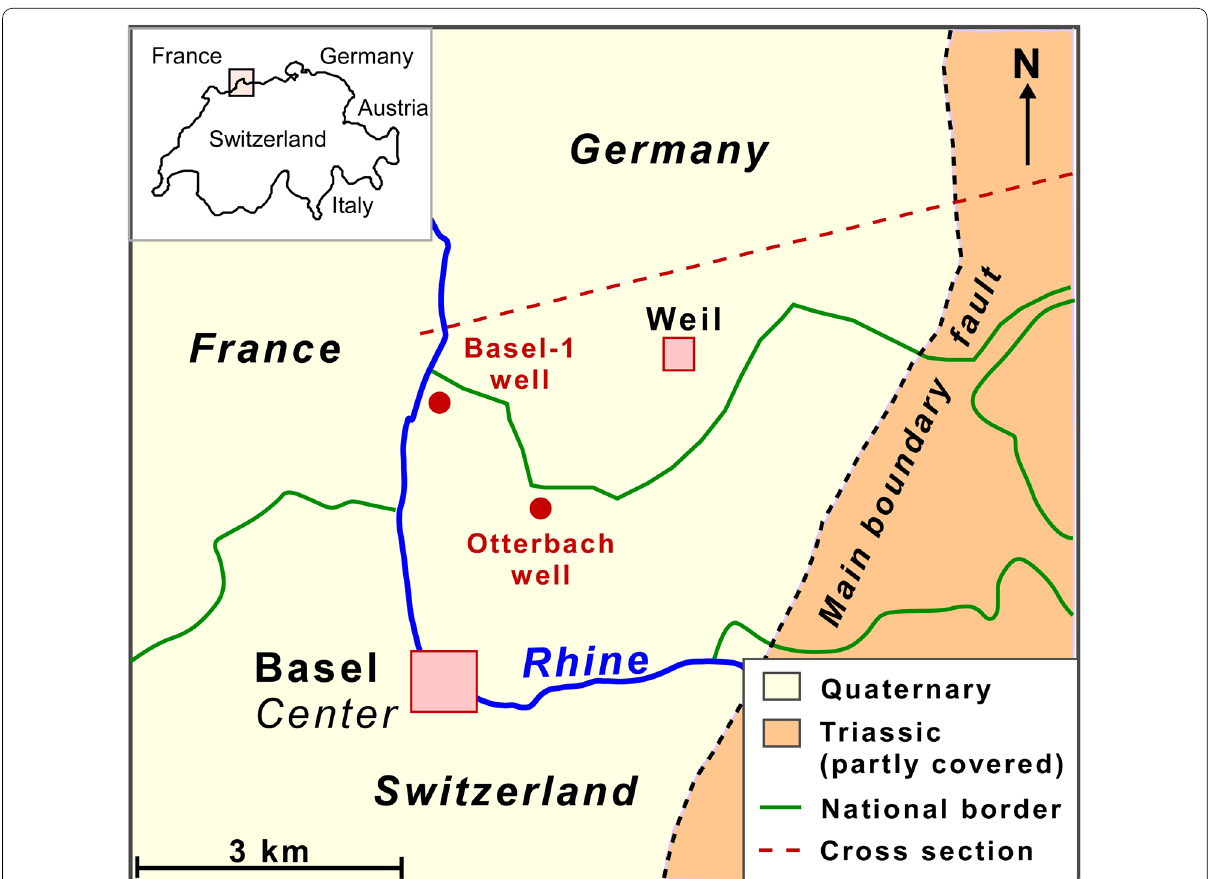
Fig. 1 Location of the investigated borehole Basel-1 and the Otterbach well in northern Switzerland, near the river Rhine. The geological cross section is shown in Fig.